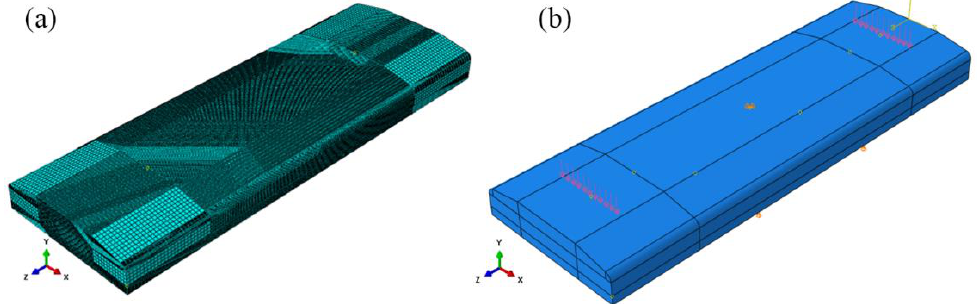
Figure 3. ( a ) Schematic of the 3D FEM model of specimen for LSP; ( b ) load and boundary constraints for the four-point bending specimen.